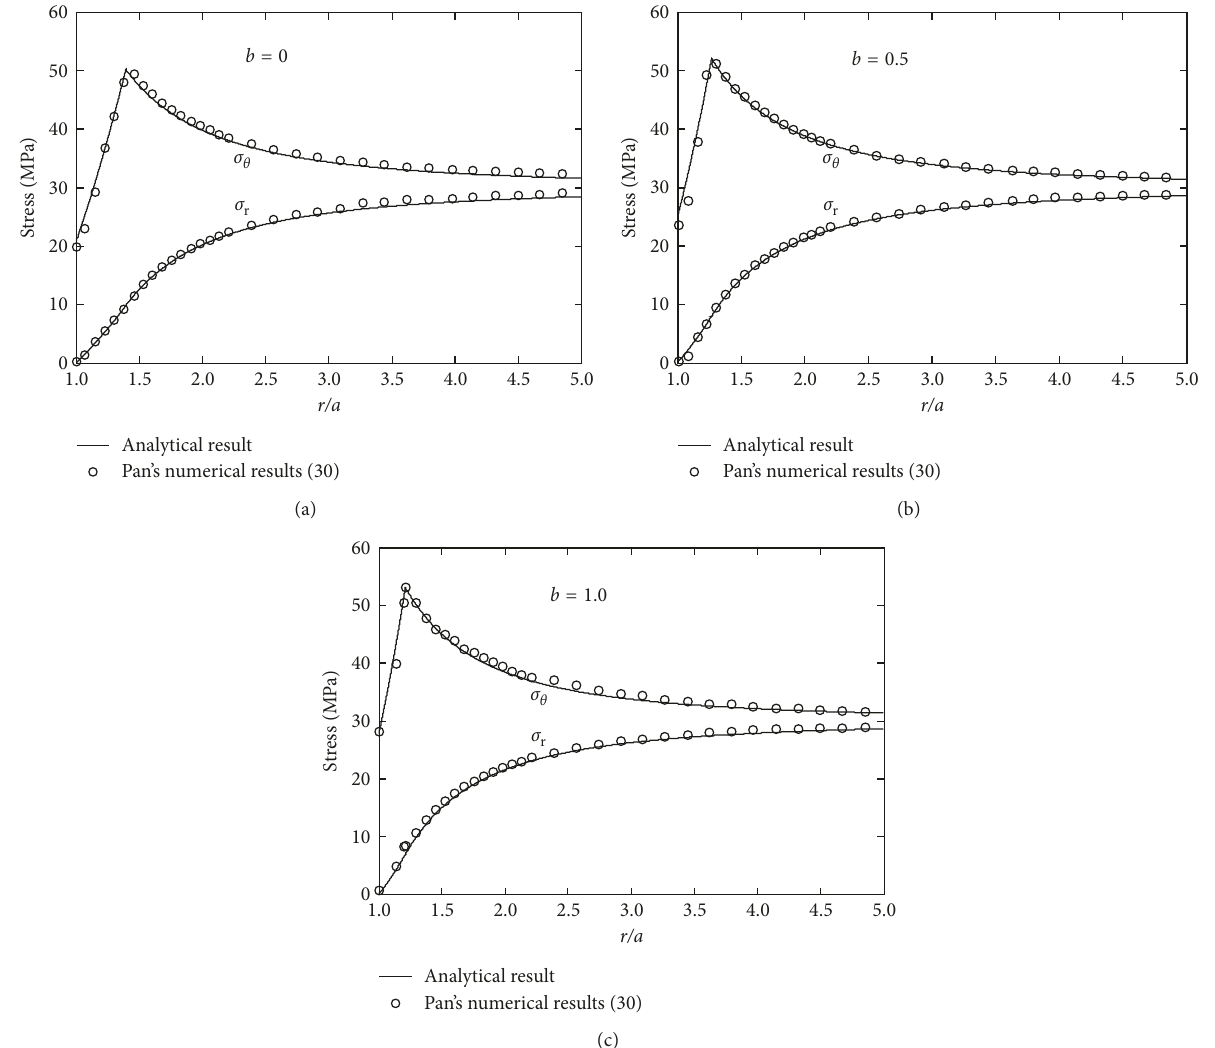
Figure 4: Contrast of stress distribution. Table 2: Geometrical and mechanical parameters by Ogawa and Lo